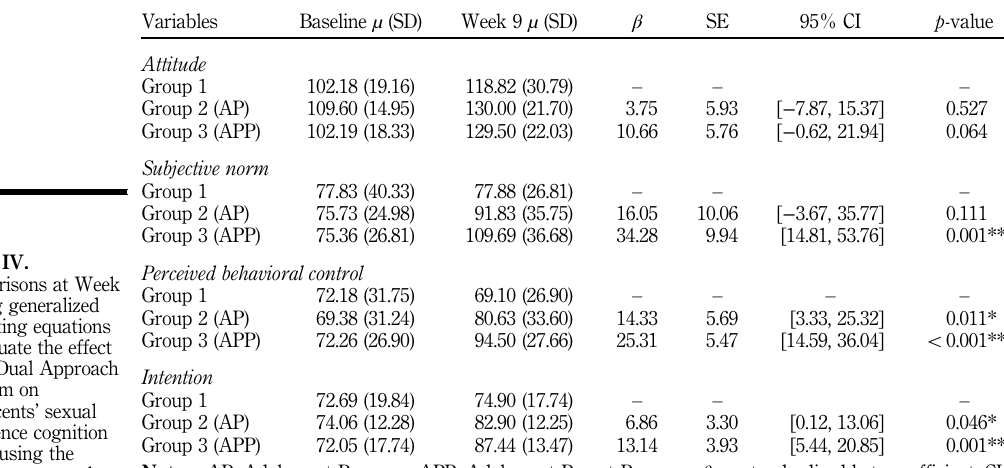
9 using generalized estimating